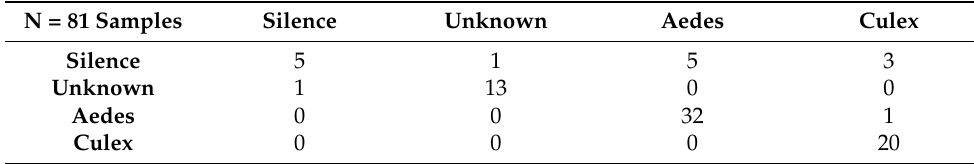
Table 10 summarizes the classification algorithm implemented in the device to classify 81 recorded audio files where we have 11 false positives and 70 true positives. The input data are contained in an audio file with a 16 kHz sampling rate and a 1-second time frame after being activated by the optical system. Table 10. Confusion matrix for 81 files. N = 81